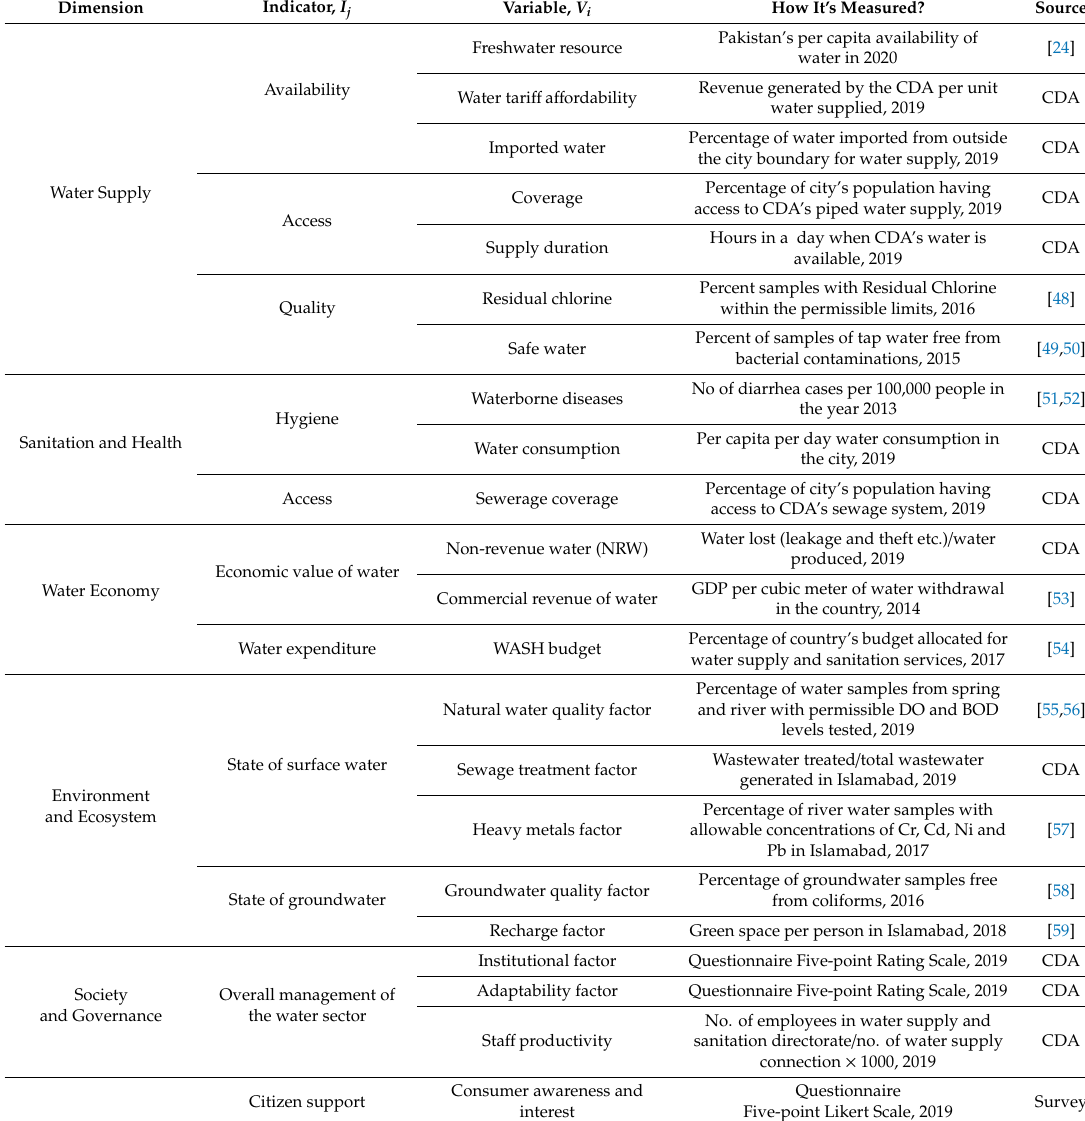
Table 1. Islamabad’s urban water security dimensions, indicator, and